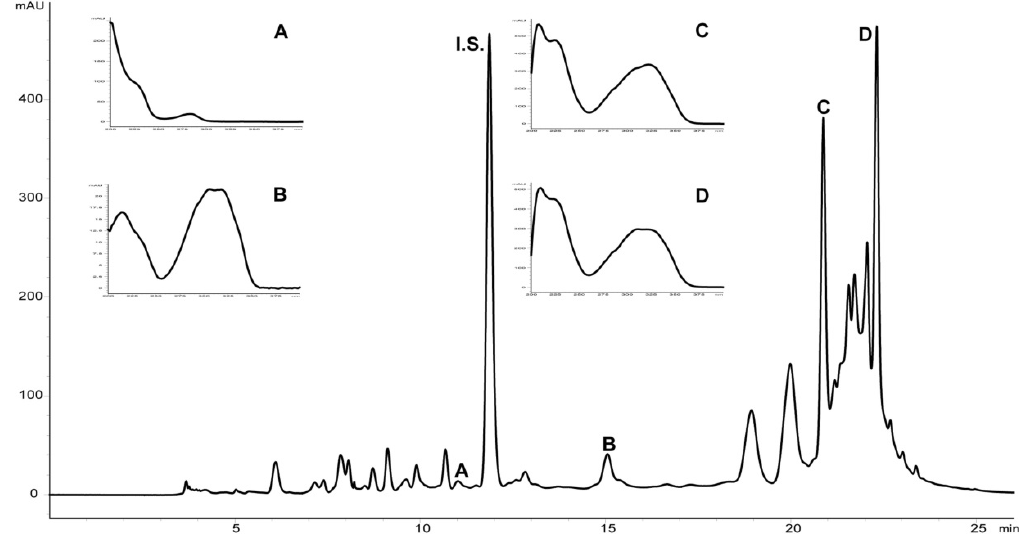
Figure 2. HPLC analysis of extracts from grapevine cell cultures on the 13th day of cultivation, that is, 7 days after treatment with TvC2. A—trans-piceid, B—trans-resveratrol, C— ε -viniferin, D— δ -viniferin, I.S.—internal standard (ferulic acid). Table 1. The mean content of stilbenes in control and elicited (on the 6th day) grapevine cells cultured in vitro ( µ g/g, a–g statistically significant differences between values, n.d. not